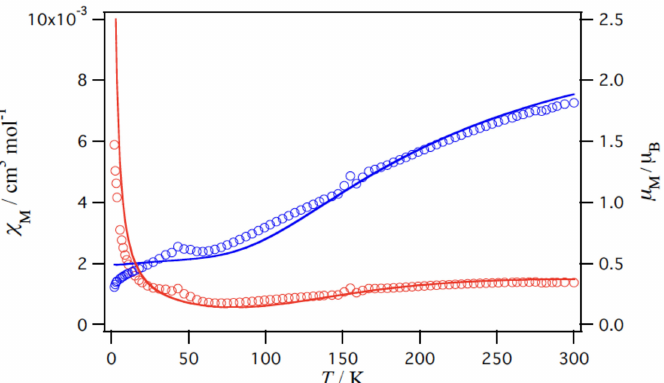
Figure 5. Temperature dependence of magnetic susceptibility χ M ( ◦ ) and magnetic moment µ eff ( ◦ )